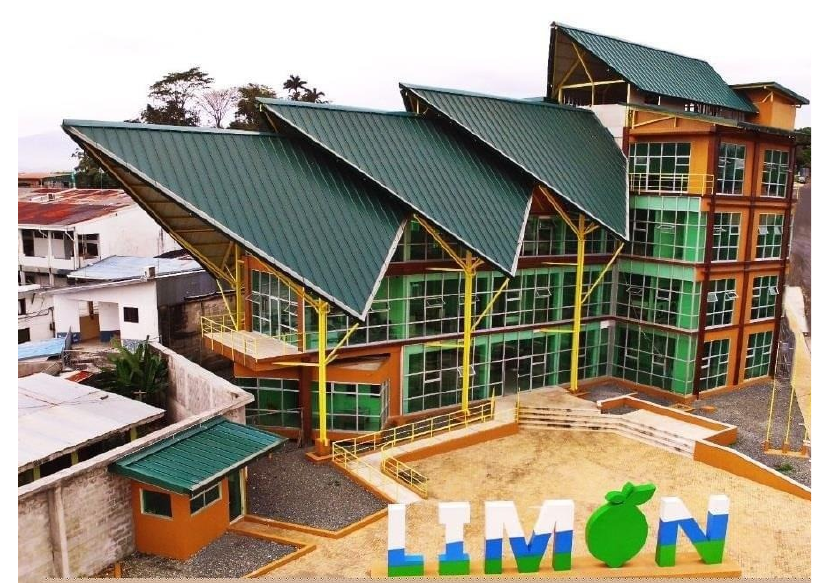
Municipal Building of Limón, ©Johnny